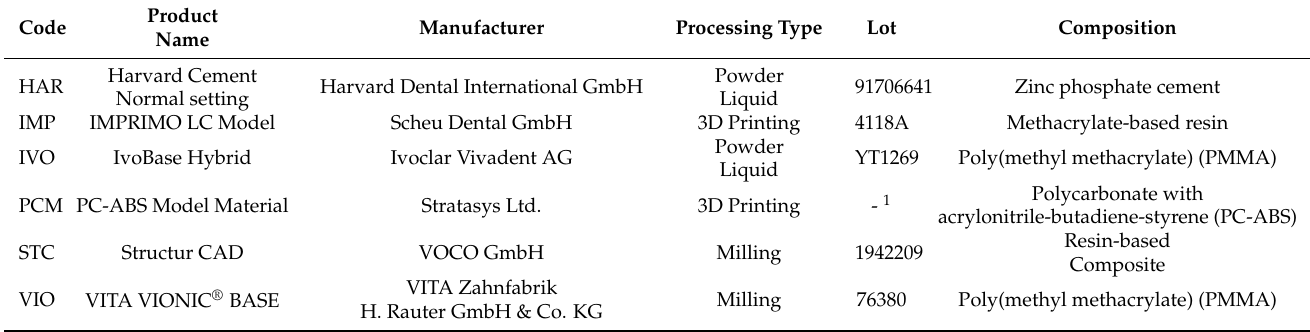
Table 1. Materials investigated in the current study and information on composition and processing type as issued by the